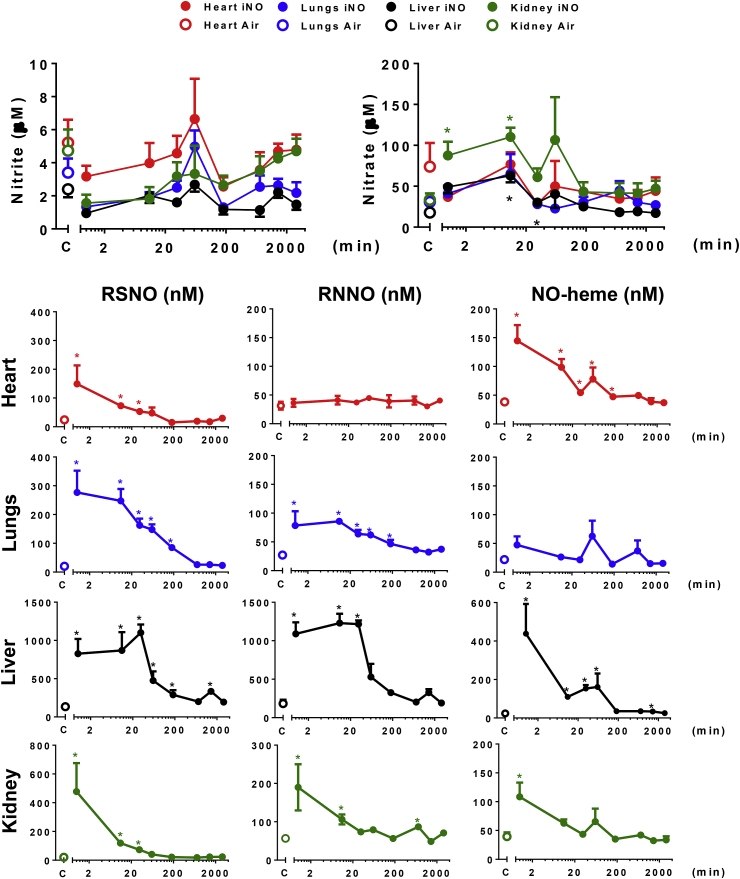
Distribution and kinetics of NO metabolites in the tissues (heart, lungs liver and kidney). Distribution and kinetics of accumulation of NO metabolites in mice breathing NO (heart, lungs, liver and kidney). Concentrations of NO metabolites were measured in tissues of mice breathing air with 80 ppm NO for 60 min, harvested at 0, 10, 30 min, 1, 3, 6, 12, 24 and 48 h (NO, n = 3–7). Control mice breathed air for 60 min (n = 4–5). *P < 0.05 versus mice not breathing NO. C = control group. NO-heme = nitrosyl-heme species; RNNO = N-nitrosamines; RSNO = S-nitrosothiols. Additional information regarding each concentration, the number of animals studied, and the P value are available in the Supplemental Tables 2-4.